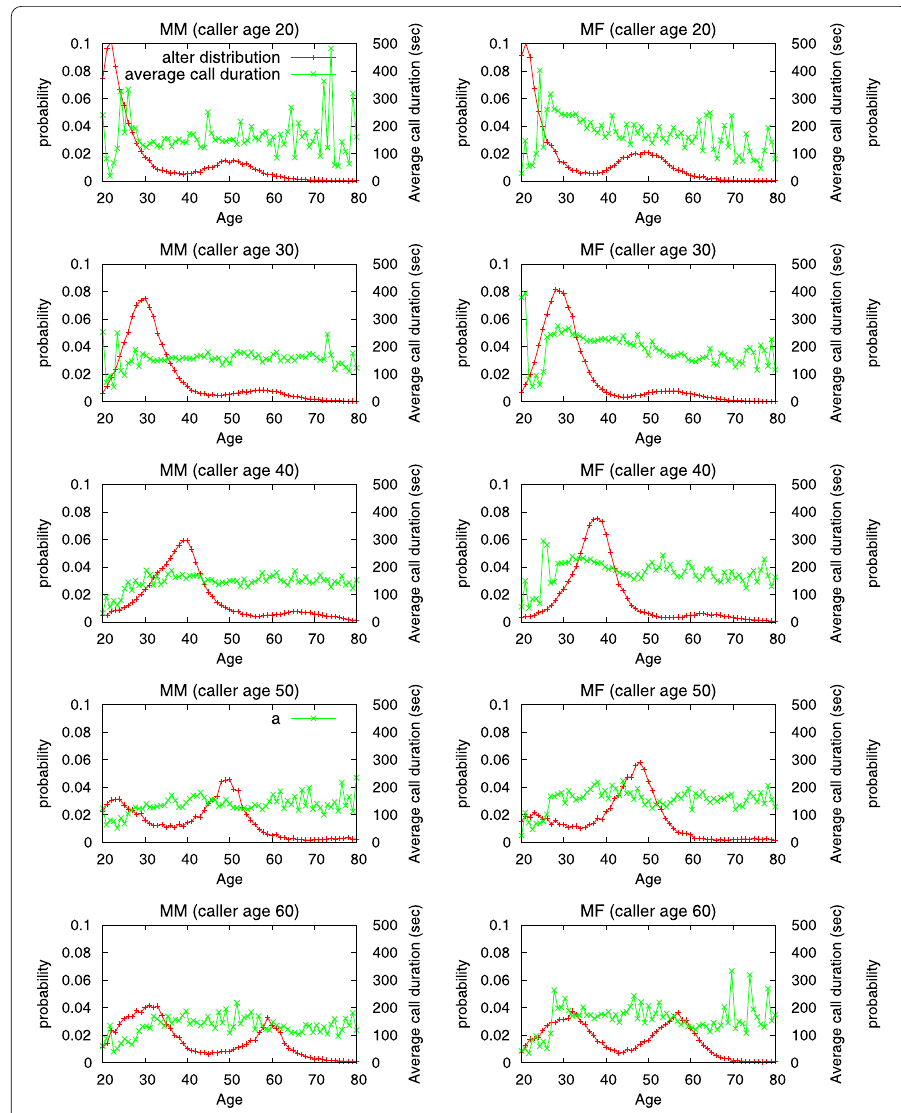
Figure 9 The distribution of calls made by the callers of different ages (i.e. 20, 30, 40, 50 and 60 years old) to callees as a function of the callees’ age (red lines; scale on the left) and correspondingly the callers’ average call duration as a function of callees’ age (green lines; scale on the